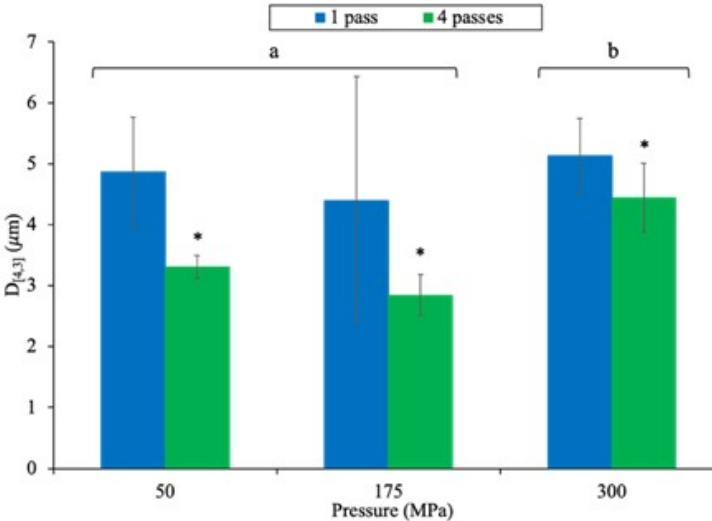
Figure 3. Impact of pressure level (50, 175 and 300 MPa) and number of passes (1—blue and 4—green) on the mean diameter expressed as volume (D [4,3] ) of pressure-treated granule (G1p). Data with different letters (a-b) and * are significantly different ( p < 0.05), due to a simple effect of pressure and passes (Tukey test, α = 0.05, n = 3).